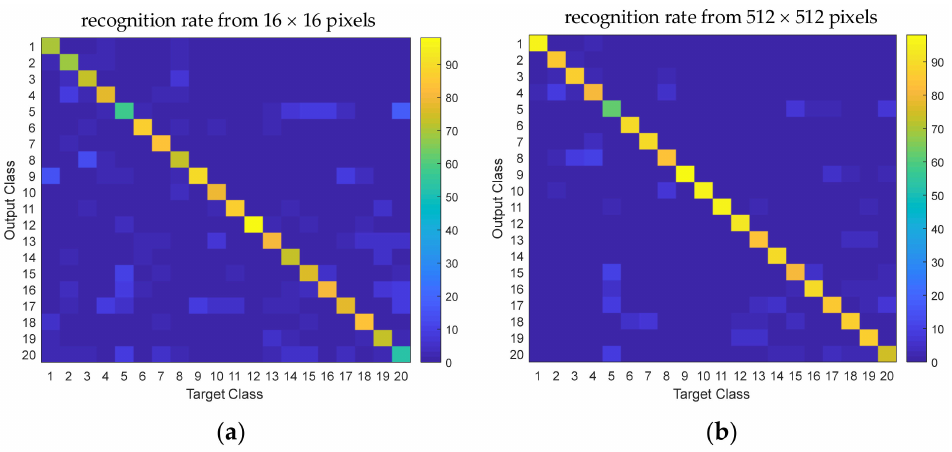
Figure 19. Confusion matrices were obtained using DCNN for 20 classes of objects: ( a ) Tactile image resolution 16 × 16 pixels without resolution enhancement; ( b ) Tactile image with enhanced resolution of 512 × 512